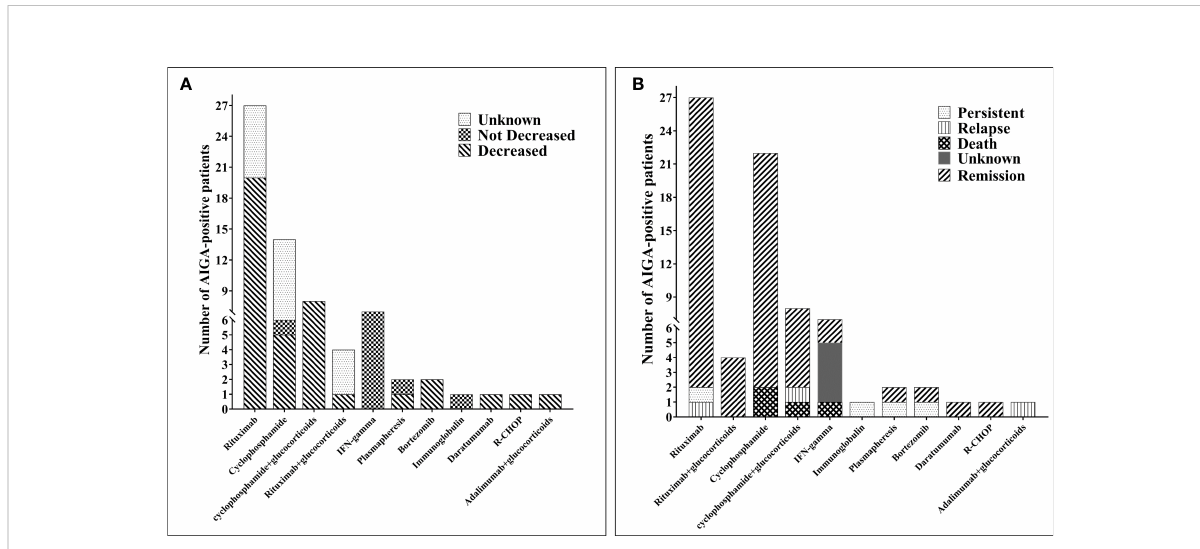
FIGURE 5 Immunotherapy of 67 patients with anti-interferon- g autoantibodies positivity. (A) The number of changes in the AIGA titer of anti-interferon- g autoantibodies positivity patients after immunotherapy. (B) The outcome of patients with anti-interferon- g autoantibodies positivity after immunotherapy. CTX, cyclophosphamide; MP, methylprednisolone; RTX,